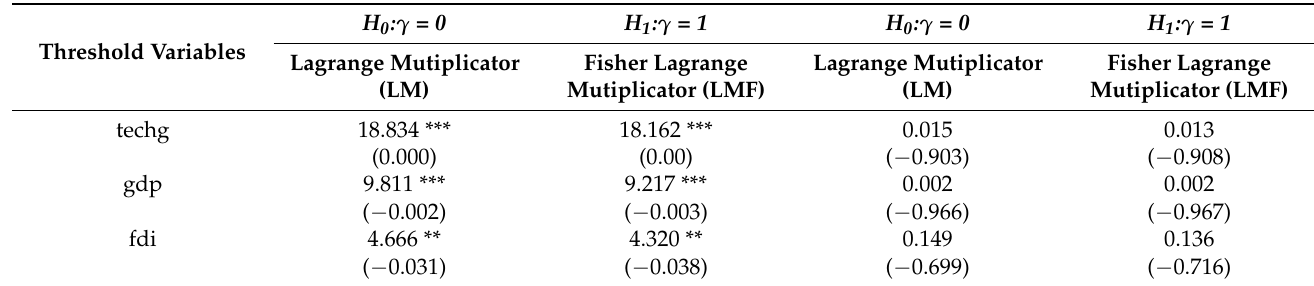
Table 4. Non-linear test results.